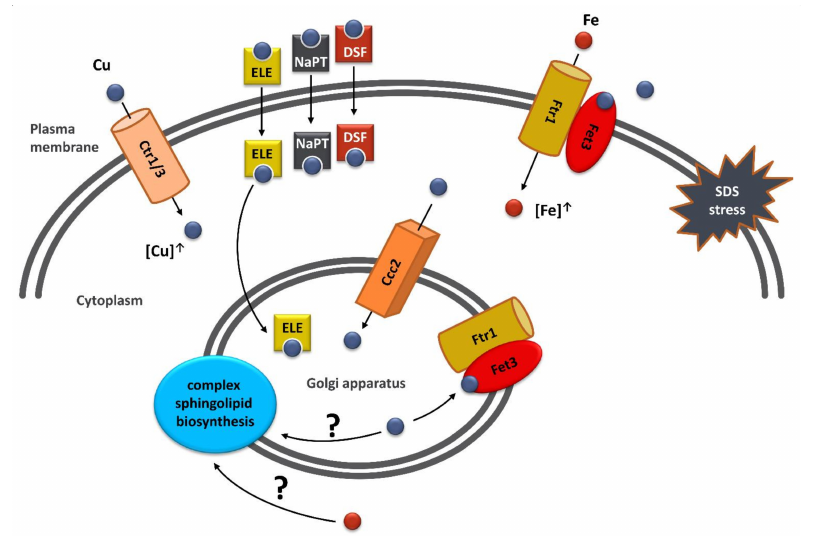
Figure 8. Schematic representation of the proposed model of copper-based suppression mechanism of vps13 ∆ SDS hypersensitivity phenotype. Stress triggered by SDS in the cytoplasm and in the plasma membrane is suppressed by increased copper uptake either by overexpression of the genes of the plasma membrane copper transporters Ctr1 or Ctr3, or by treatment with copper ionophores (ELE—elesclomol; NaPT—sodium pyrithione or DSF—disulfiram). Internalized copper is trans- ported to the Golgi apparatus by Ccc2 ATPase or by elesclomol, which is also active even in the absence of Ccc2. Then, copper is incorporated into Fet3 oxidase, which, together with Ftr1 permease, forms a complex responsible for the high-affinity iron uptake. This complex is transported to the plasma membrane, where it facilitates iron uptake. Iron is essential for protection against SDS stress and iron deficiency impairs lipid synthesis, altering the properties and functions of cellular mem- branes. When copper is abundant in the environment, it could be also directly incorporated into Fet3 localised on the plasma membrane. Another possible (yet not investigated here) putative mechanism of copper action is its direct impact on complex sphingolipid biosynthesis in Golgi apparatus, which are important for SDS stress response